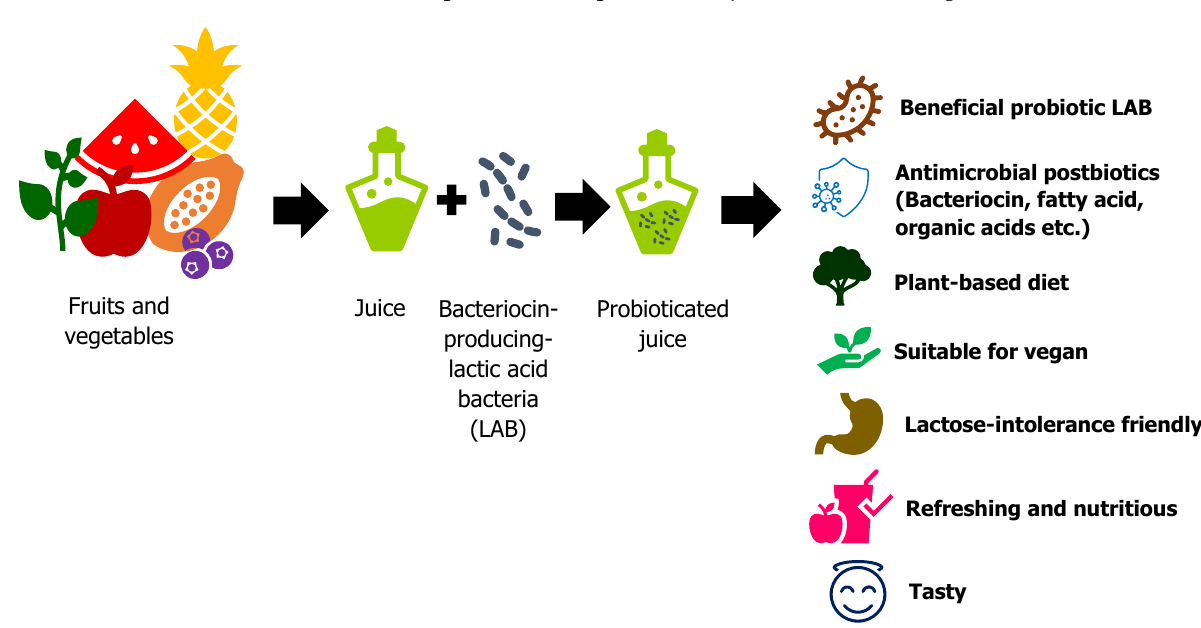
Figure 1. Stages in probiotication of fruits and vegetables juice.